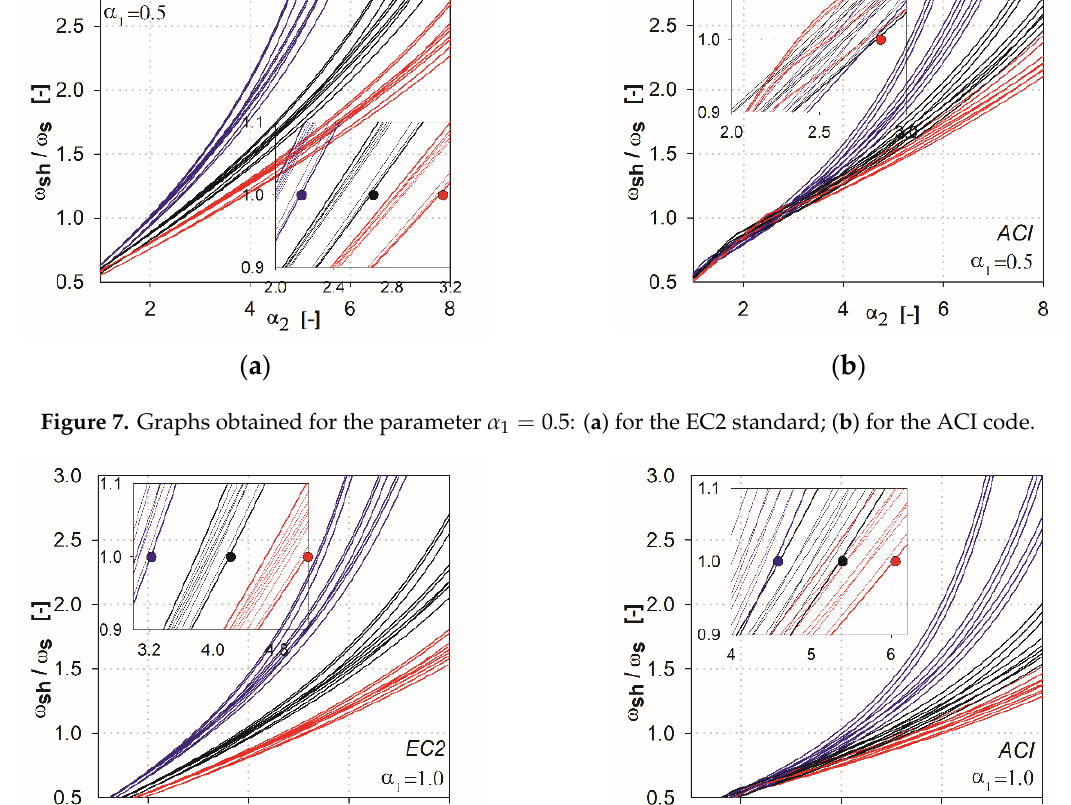
Figure 8. Graphs obtained for the parameter 𝛼 1 = 1.0 : ( a ) for the EC2 standard; ( b ) for the ACI code.